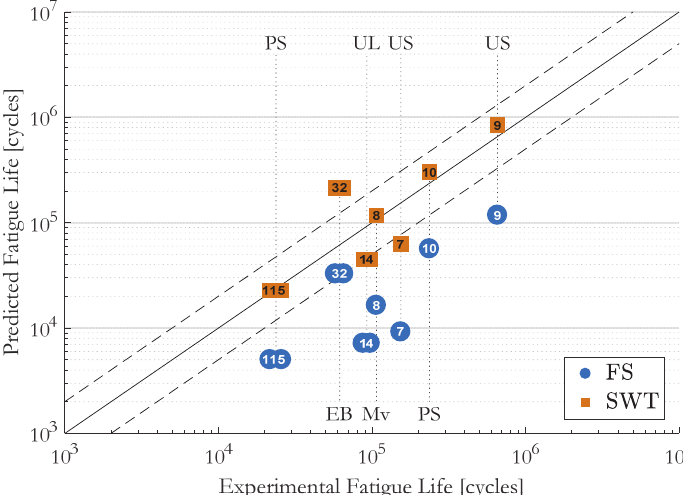
Figure 5: Fatigue life predicted with Fatemi-Socie and Smith-Watson-Topper parameters.